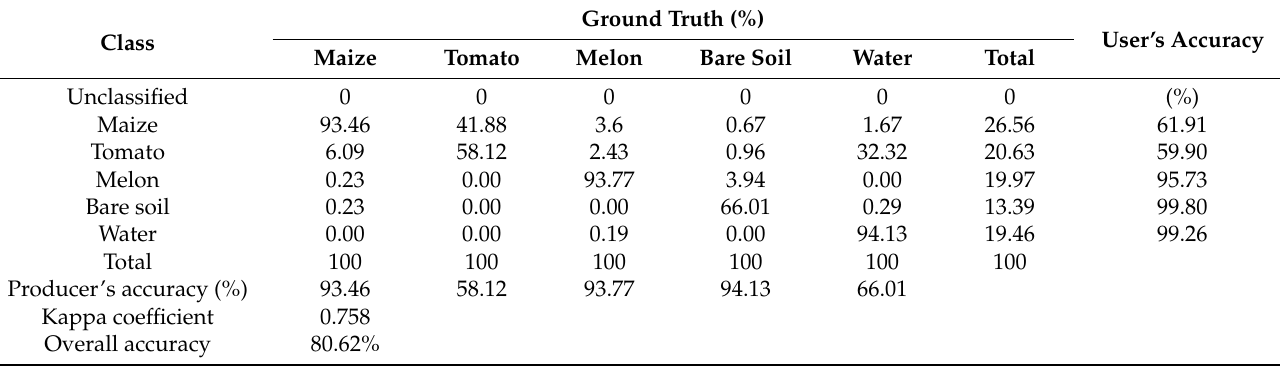
Table 5. Confusion matrix results for k-means algorithm of maize and other crops in south-west Alexandria, Egypt.